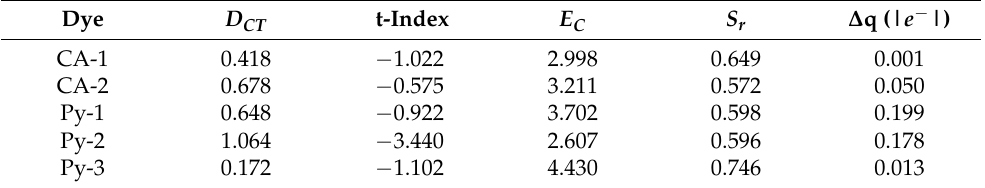
Table 4. Charge transfer descriptors and Δq, the net number of charge transferred to the anchor.